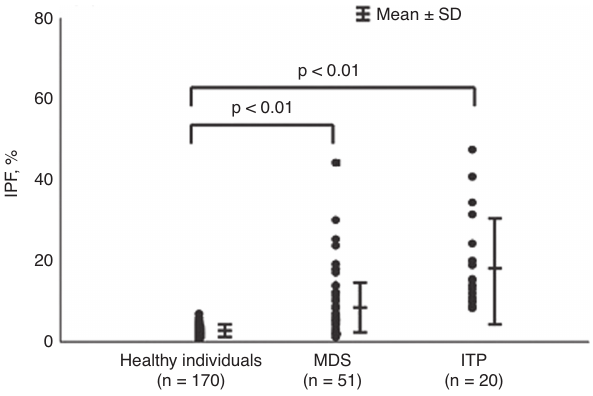
Figure 3: Immature platelet fraction in healthy individuals and patients with myelodysplastic syndrome [51]. Immature platelet fraction in healthy individuals and patients with thrombocytopenia. IPF values as determined by Sysmex XE-2100 are plotted for healthy individuals (mean IPF of 2.07%, SD ± 1.06%), patients with myelodysplastic syndrome (mean IPF of 8.80%, SD ± 8.09%) and patients with immune thrombocytopenia (mean IPF of 18.1%, SD ± 11.5%). IPF, immature platelet fraction